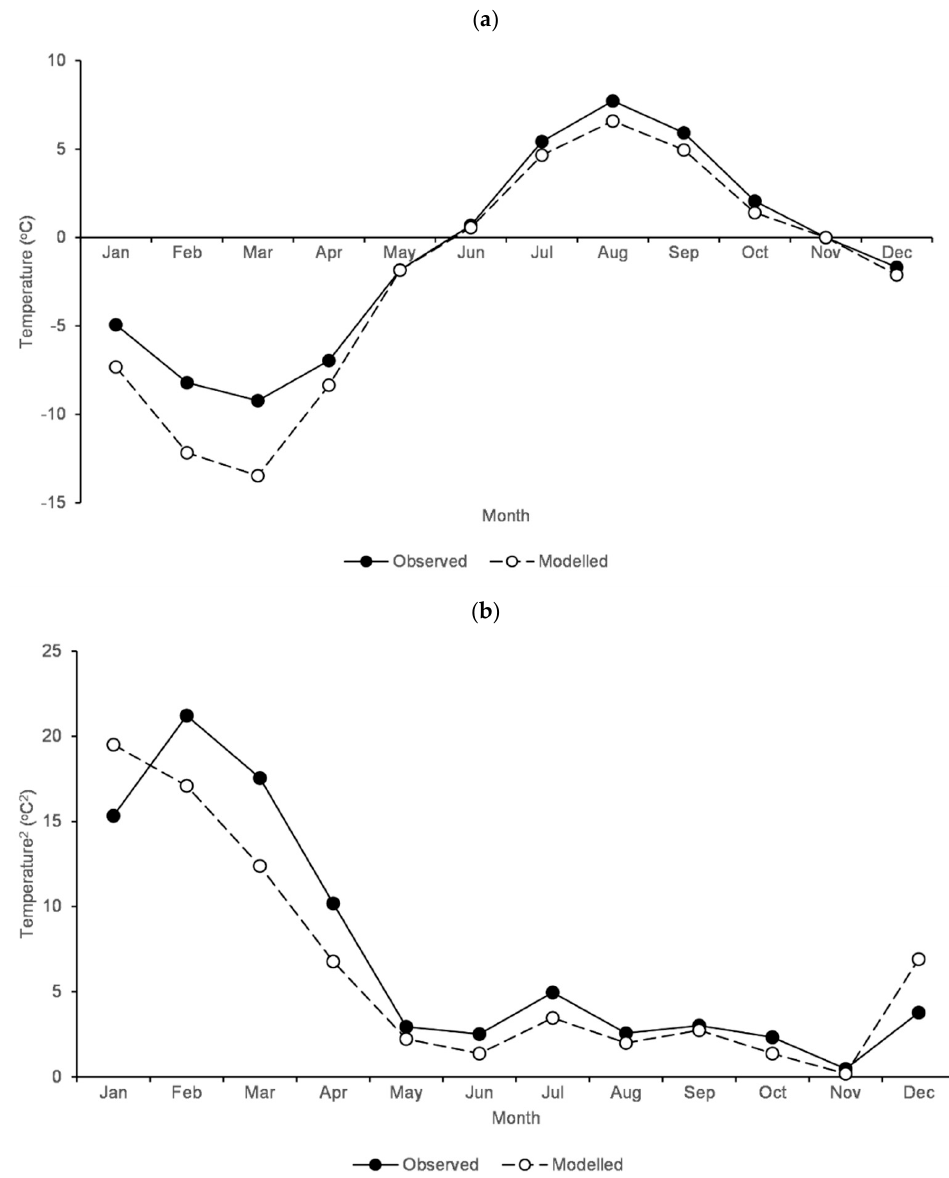
Figure 7. Comparison between the observed monthly 100 cm soil temperature and the predicted values from the CanESM2 and NCEP models for: ( a ) mean; ( b ) variance.